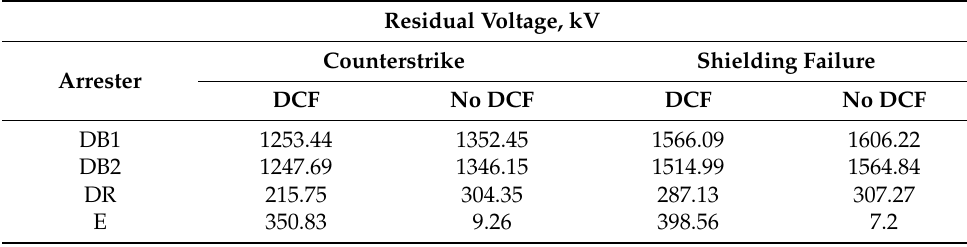
Table 10. Residual voltages of arresters for lightning